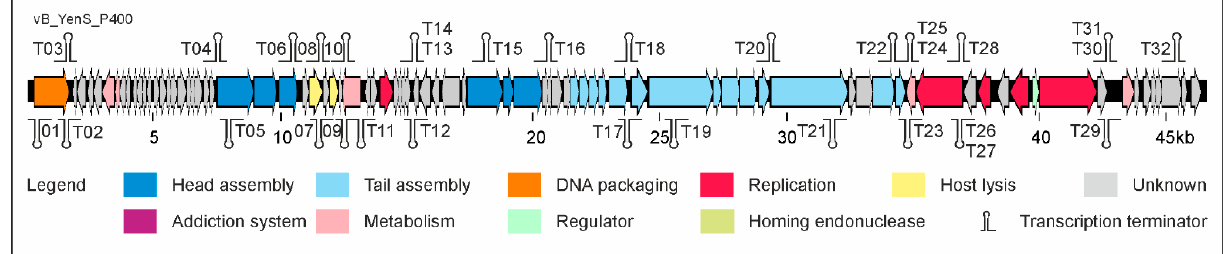
Figure 3. Gene map of vB_YenS_P400.